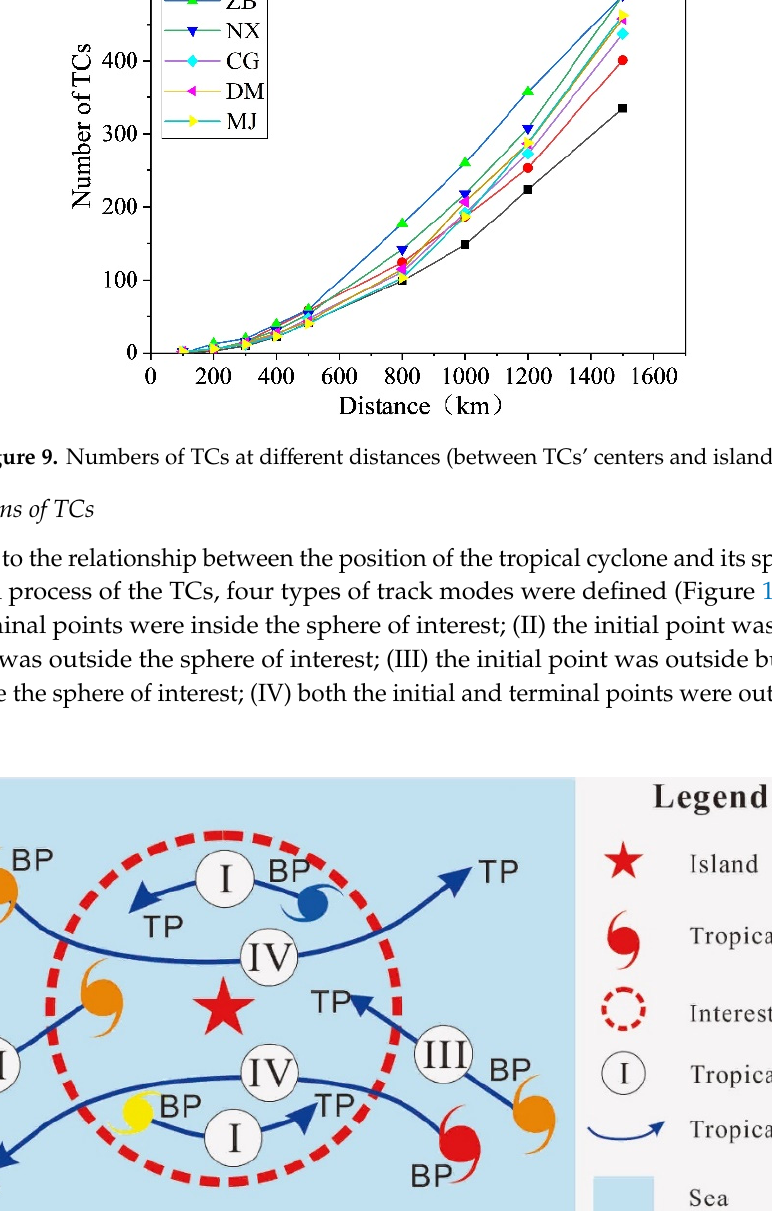
Figure 11. Numbers of TCs in four track patterns. ( a ) 500 km radius; ( b ) 800 km radius. Figure 11 shows the numbers of TCs in four track patterns with radii of 500 and 800 km over the 18 years. Track patterns II and IV represented the greatest numbers. Track pattern I existed only in HY and YS when the radius was 500 km (Figure 11a), while it did not exist only in MJ when the radius was 800 km (Figure 11b). TCs of track pattern II occurred 5–14 times in the seven islands within the radius of 800 km, but that number was about half within the radius of 500 km. For instance, there were 14 TCs of track pattern II (the most) in ZB and 5 (the least) in HY when the radius was 800 km, while there were 7 and 1, respectively, when the radius was 500 km. Track pattern III happened 5–9